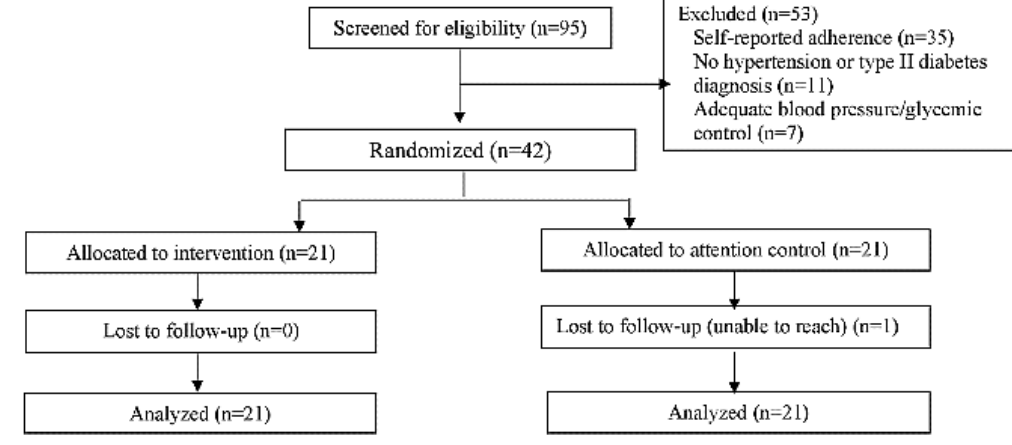
Figure 1. CONSORT (Consolidated Standards of Reporting Trials) flow